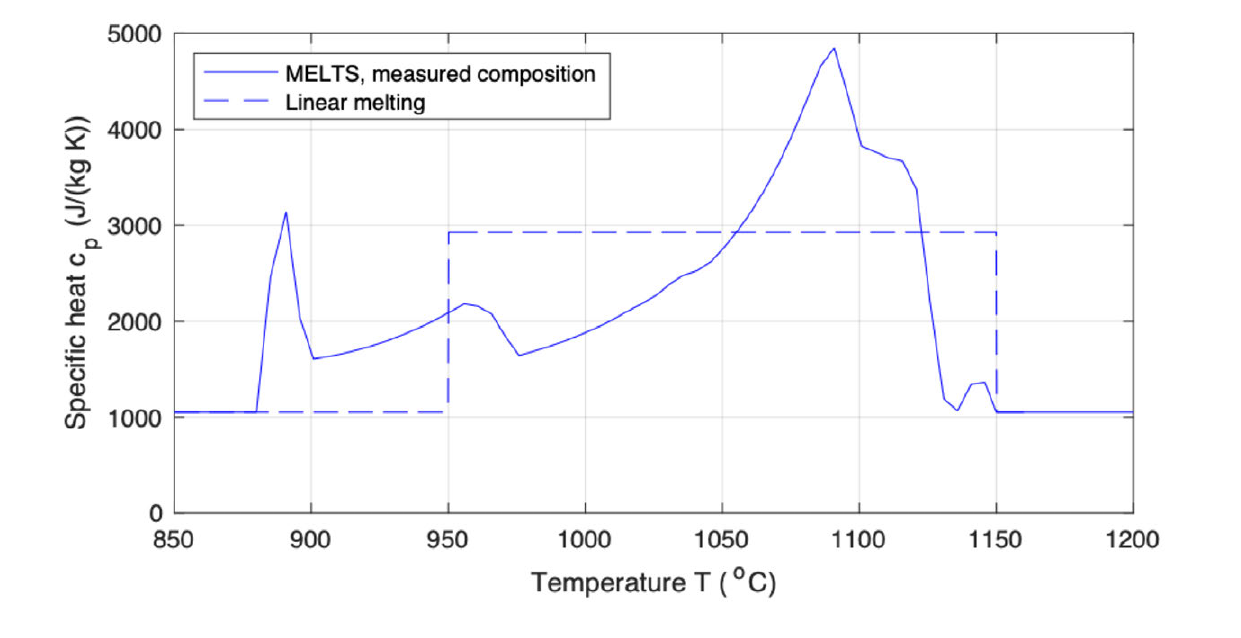
Figure D2: Specific heat as function of temperature. The solid line is based on the melting function f(T) from MELTS using the partly wet composition. The dashed line is based on the linear melting assumption. Note that both models use the same value of the enthalpy of fusion L , and hence the areas under the two curves are equal. By comparison with the dry melting curve in Figure D1, it is observed that the sharp peak of the specific heat function at 885 °C as well as the elevated values up to 970 °C are due to the presence of